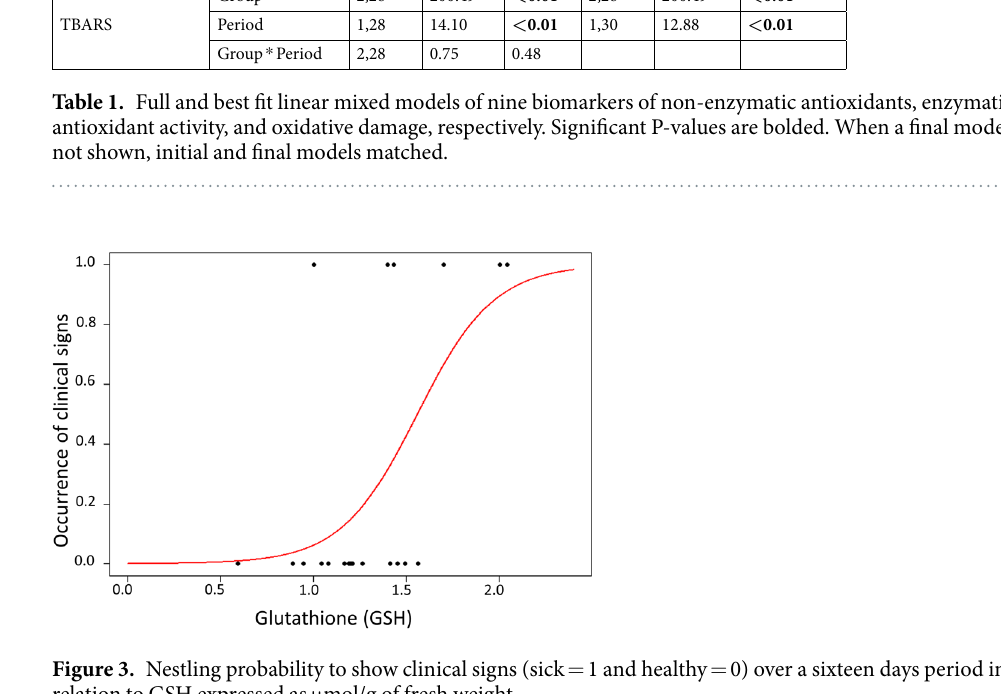
Figure 3. Nestling probability to show clinical signs (sick = 1 and healthy = 0) over a sixteen days period in relation to GSH expressed as μ mol/g of fresh